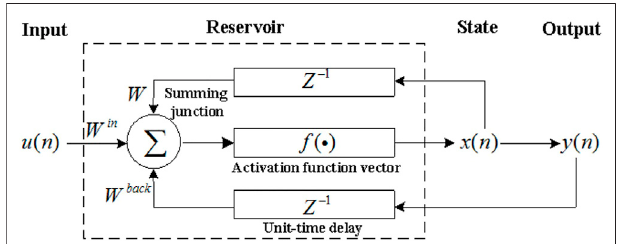
FIGURE 1 | Architecture of the echo state